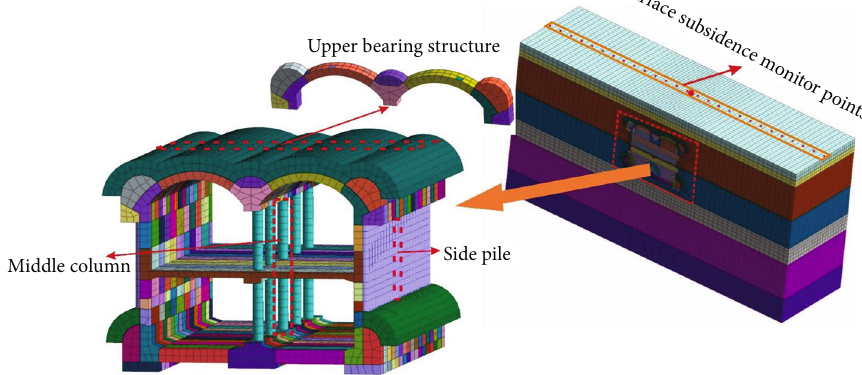
Figure 6: Numerical